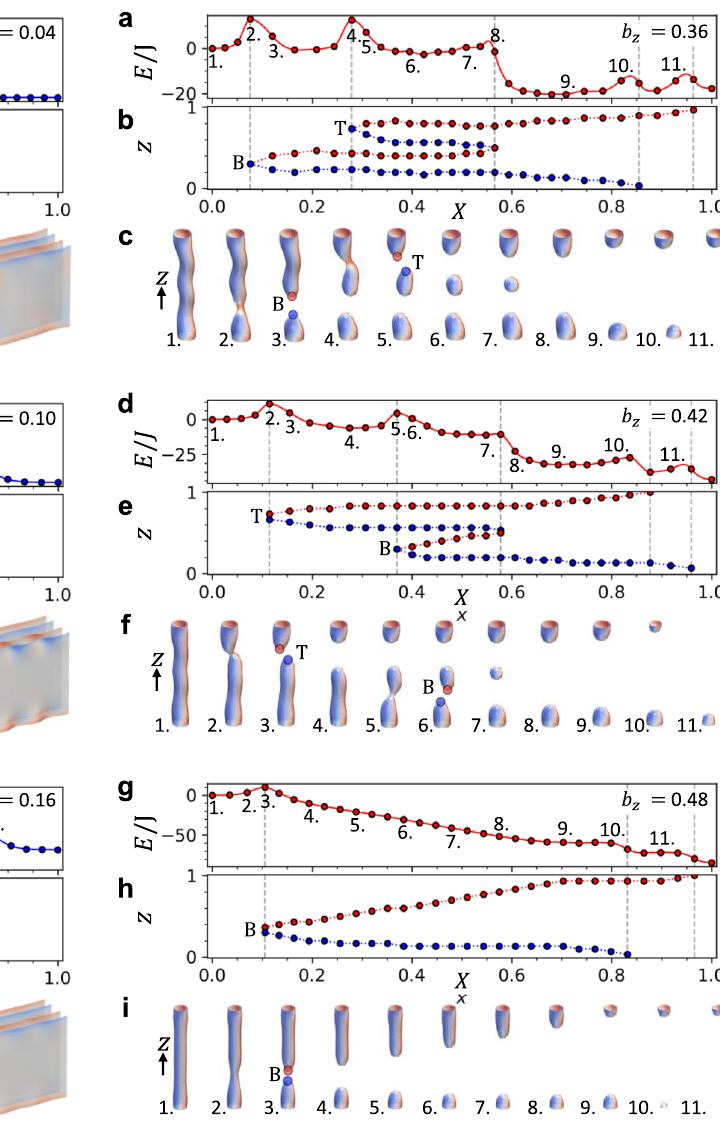
Fig. 5 Skyrmion to conical annihilation energy barrier simulations. a – i The results of the simulations for the skyrmion lattice to conical decay mechanism are shown at a range of applied magnetic fi elds. a , d , g The energy dependence of the magnetic state is plotted as a function of the reaction coordinate X along the minimum energy path (MEP). All data points have been subtracted by the energy of the initial state. b , e , h The z -axis trajectory of the top (T) and bottom (B) pairs of Bloch points plotted as a function of X as the skyrmion tube is annihilated. Vertical dashed lines highlight images where Bloch points are created or destroyed. Red and blue data points distinguish each Bloch point in a pair. c , f , i Selected three- dimensional visualisations of the simulation at speci fi c points along the MEP at each fi eld, as indicated by the corresponding numeric labels in ( a , d , g ). The surfaces display s z = 0 contours, and have been coloured according to the local value of s x